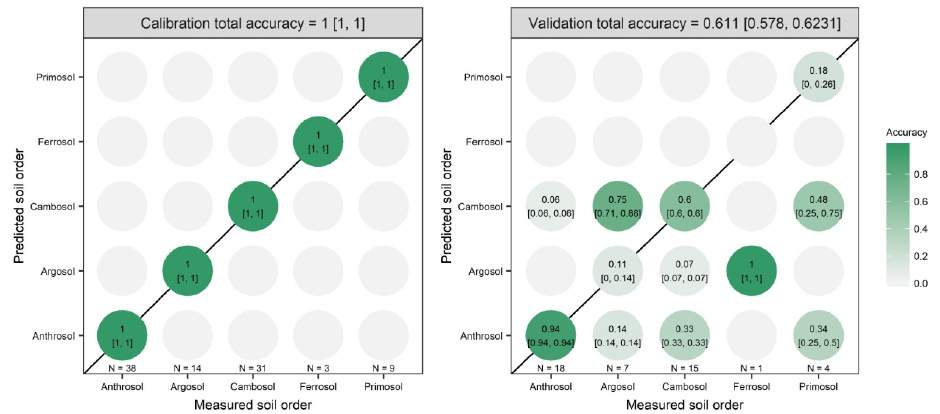
Figure 7. Confusion matrix of soil classification based on spectral combination.